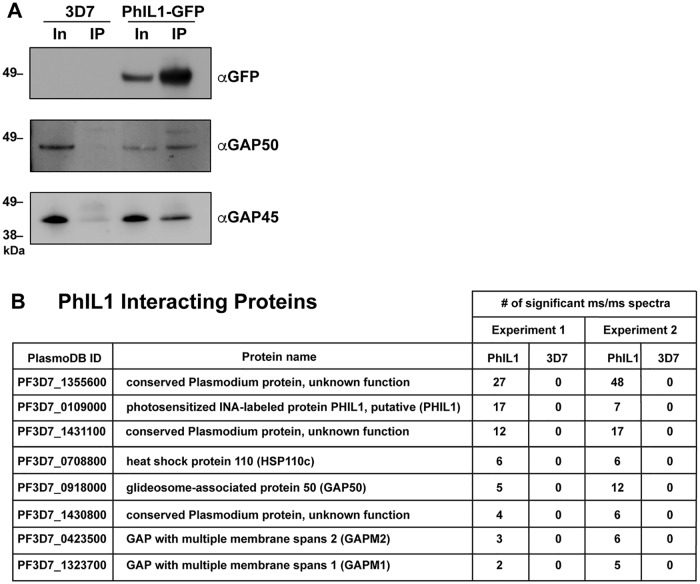
Identification of new IMC proteins in gametocytes.(A) 3D7 parent and PhIL1-GFP transfectant gametocytes, purified at stage IV, were detergent-solubilized and proteins were immunoprecipitated using GFP-Trap. The input and precipitated eluates (IP) were prepared for SDS-PAGE and Western blot and probed with anti-GFP, anti-GAP50 and anti-GAP45 antibodies. Molecular masses of markers are shown in kDa. (B) List of the PhIL1-interacting proteins. Two independent experiments were performed. Proteins that returned ≥2 significant MS/MS peptides in each experiment are included. A complete list of significant and non-significant proteins identified are presented in S2 Table.